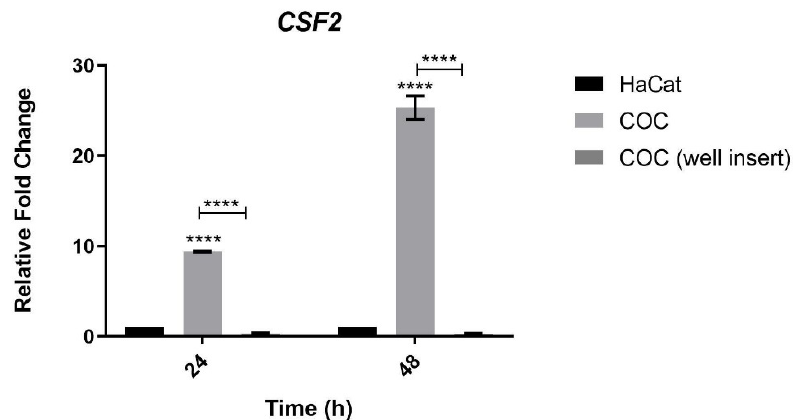
Figure 4. CSF2 gene expression levels during co-culture of human keratinocytes and T. rubrum with well inserts. HaCat: cultured keratinocytes used as control; COC: co-culture with the conidial phase of T. rubrum ; COC (well insert): co-culture with the conidial phase of T. rubrum separated by well inserts (without cell–cell contact between the pathogen and host). Asterisks indicate significant differences (**** p < 0.0001).